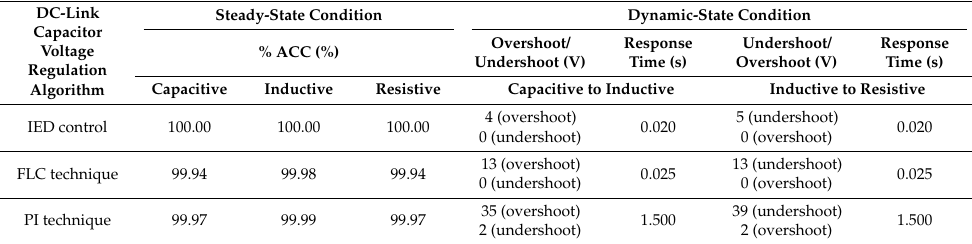
Table 6. Voltage regulation performance of each DC-link capacitor voltage regulation algorithm (simulation